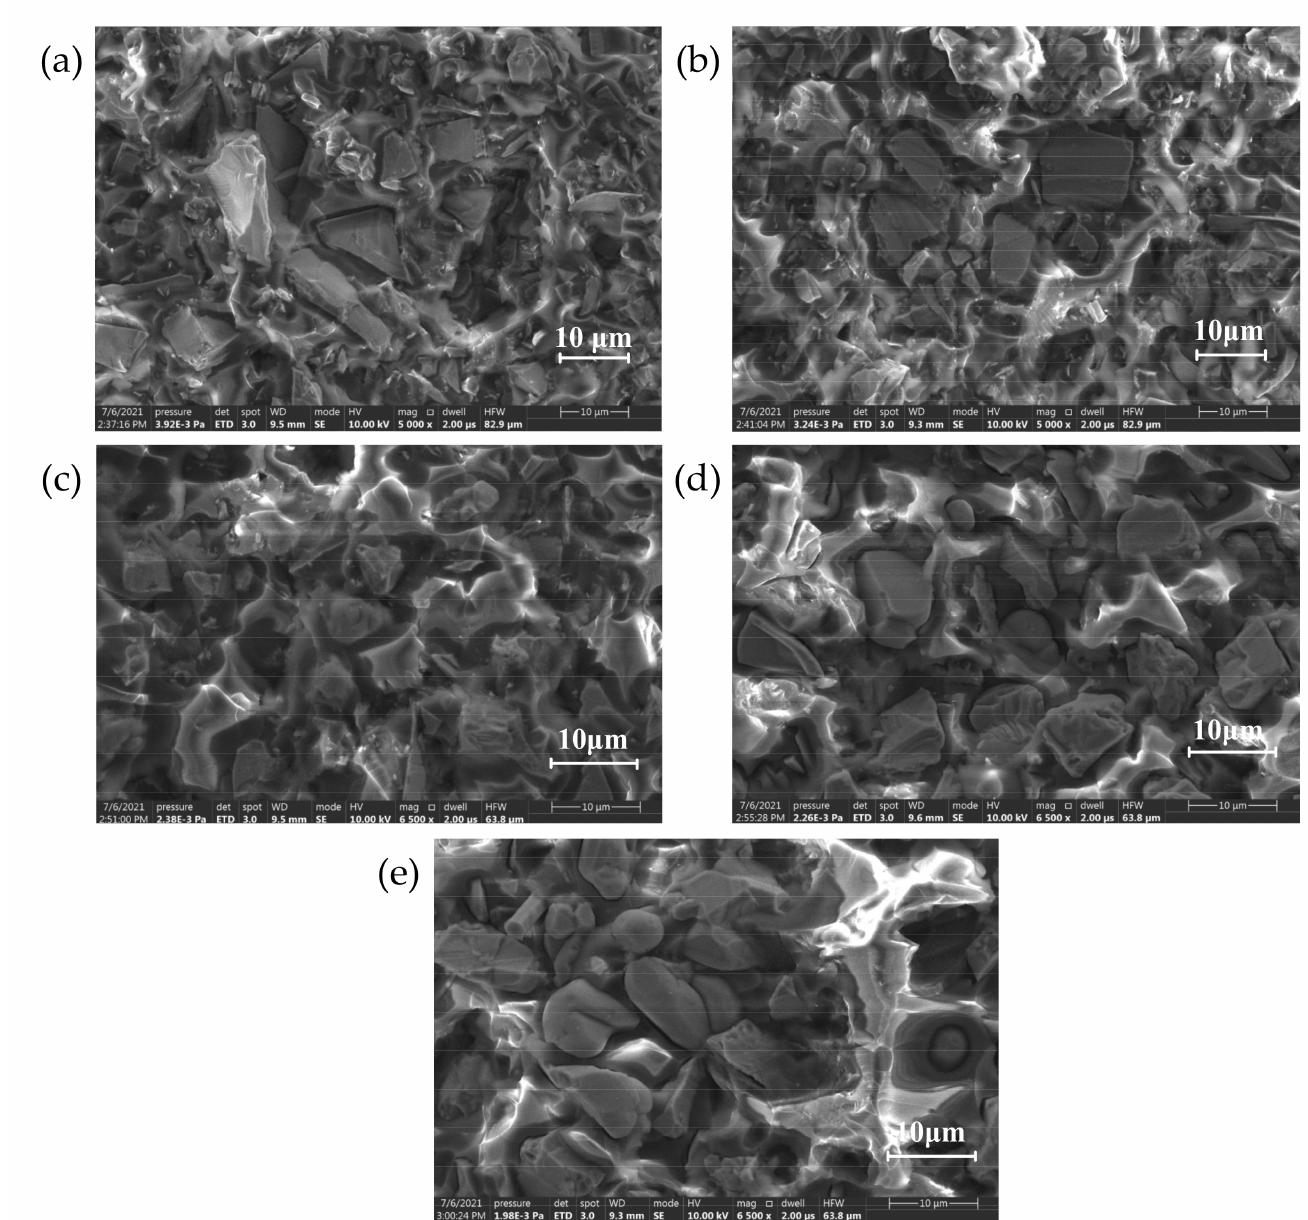
Figure 8. Sectional electron micrograph of SiC/EP composite